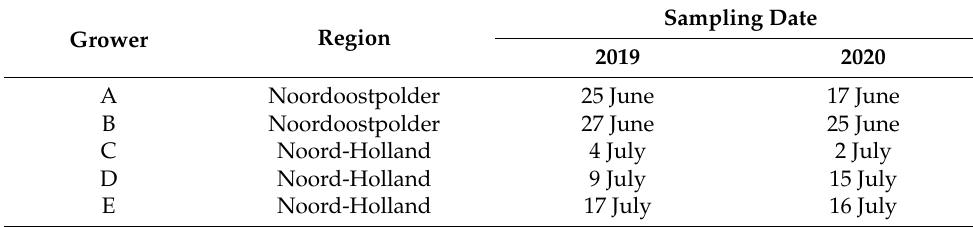
Table 1. Data on sampled growers of minitubers and sampling dates. Grower